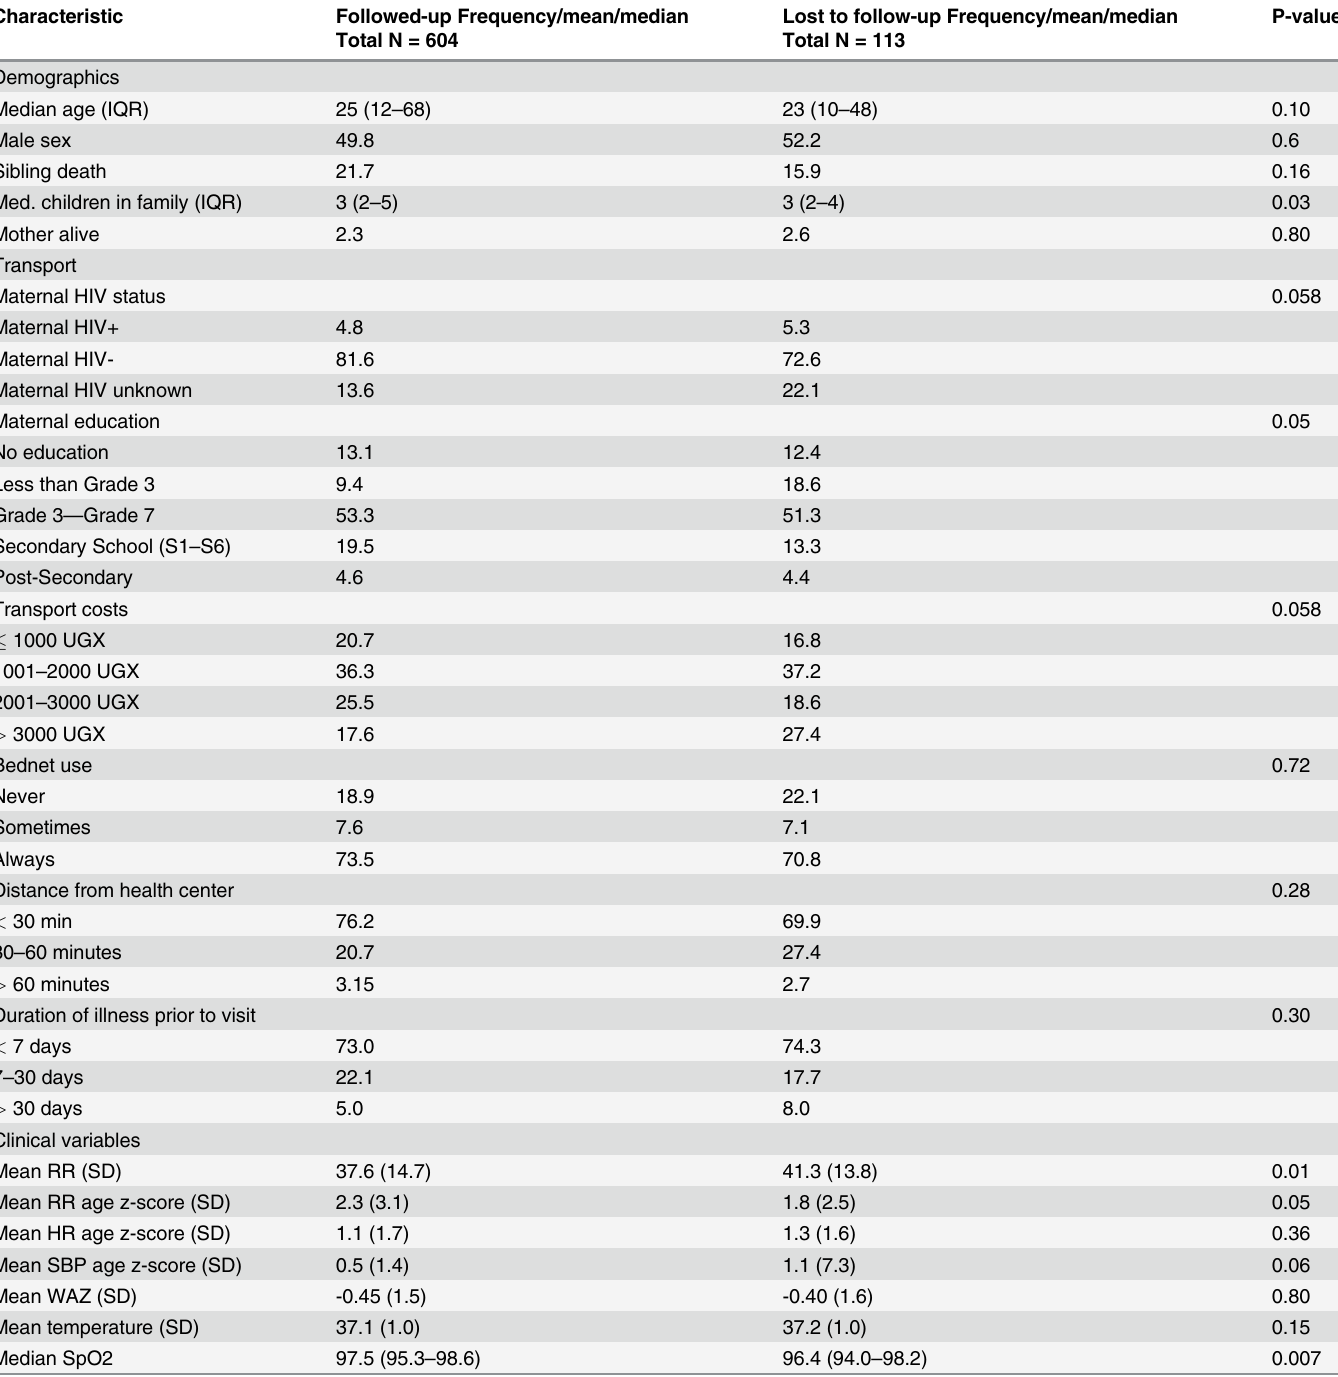
Table 5. Comparison of baseline characteristics of those followed-up and those lost to follow-up.